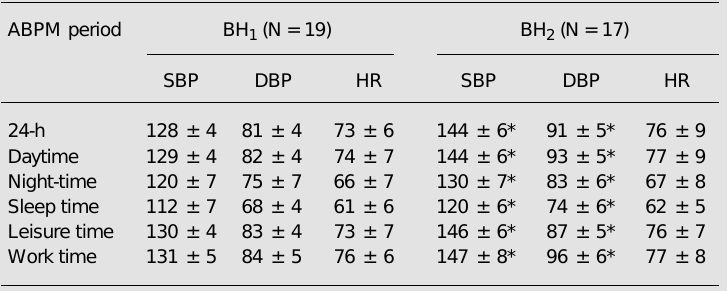
Table 3. Ambulatory blood pressure monitoring (ABPM) data showing that some borderline hypertensive subjects presented normal blood pressure levels during 24-h monitoring (BH 1 ) while others showed elevated blood pressure levels during 24-h monitoring (BH